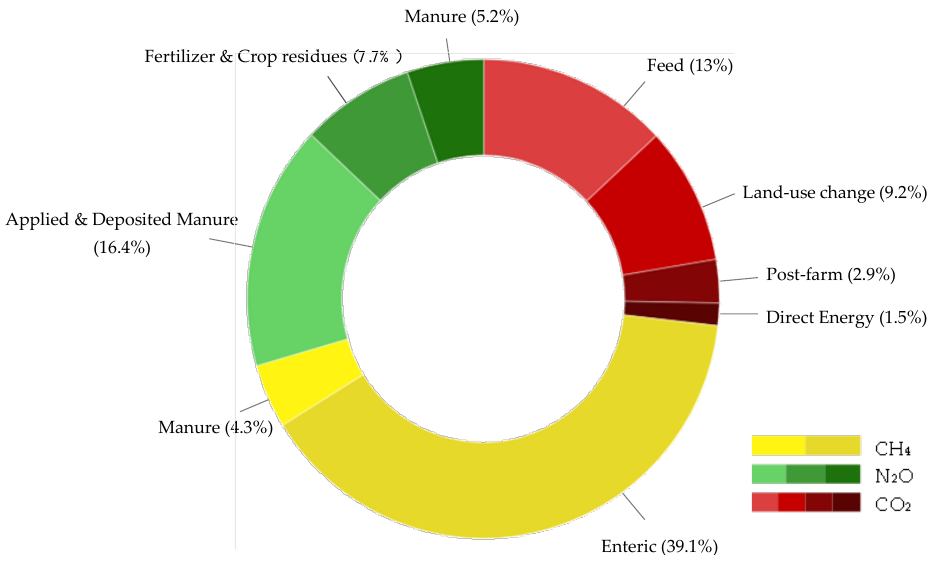
Figure 1. Emissions from livestock (by category), where methane (CH 4 ) emissions are portrayed in yellow, nitrous oxide (N 2 O) in green, and carbon dioxide (CO 2 ) in red. Figure drawn by authors with data source from [7].